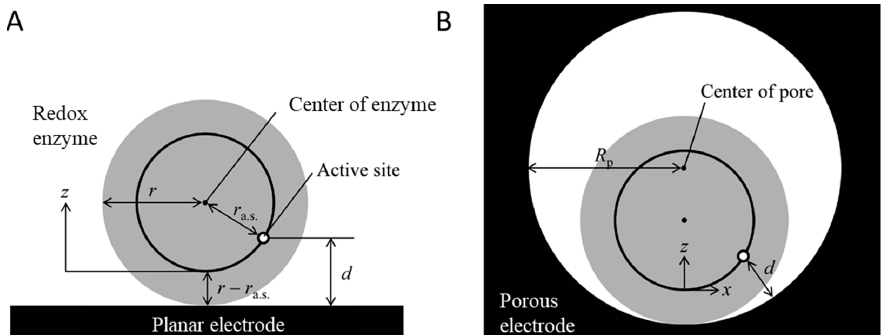
Figure 2. Schematic model of an adsorbed enzyme on ( A ) planar and ( B ) porous electrodes. Reprinted from [37]. Copyright (2016), with permission from American Chemical Society.